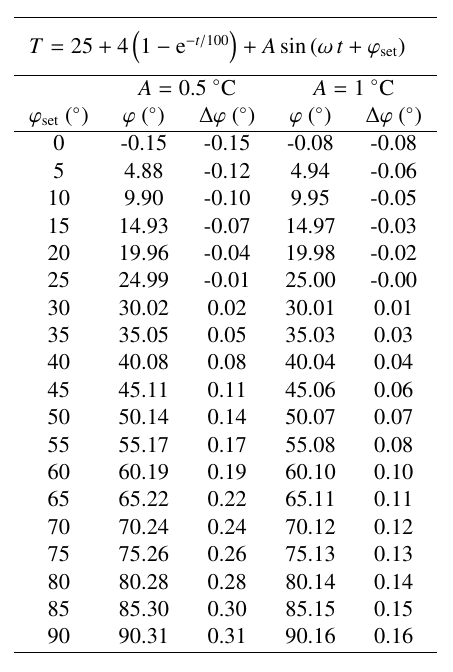
Table 2. Deviations in processing a harmonic signal with frequency 0 . 1 Hz ( ω = 2 π 0 . 1s − 1 ) superposed on the exponential function for amplitudes A = 0 . 5 ◦ C and 1 ◦ C. The sampled frequency is 10 Hz, and the signal length is 100 s.